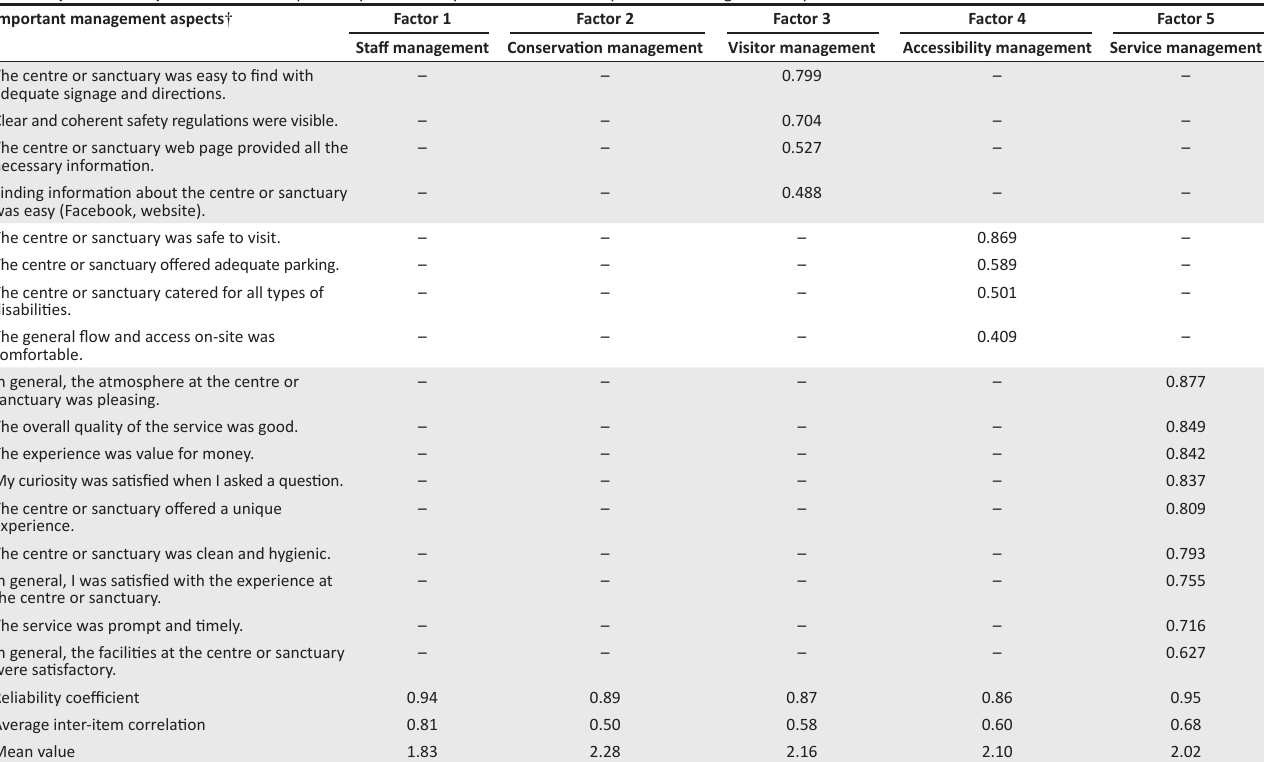
TABLE 3 (Continues...): Results of the exploratory factor analyses on the visitor experience management